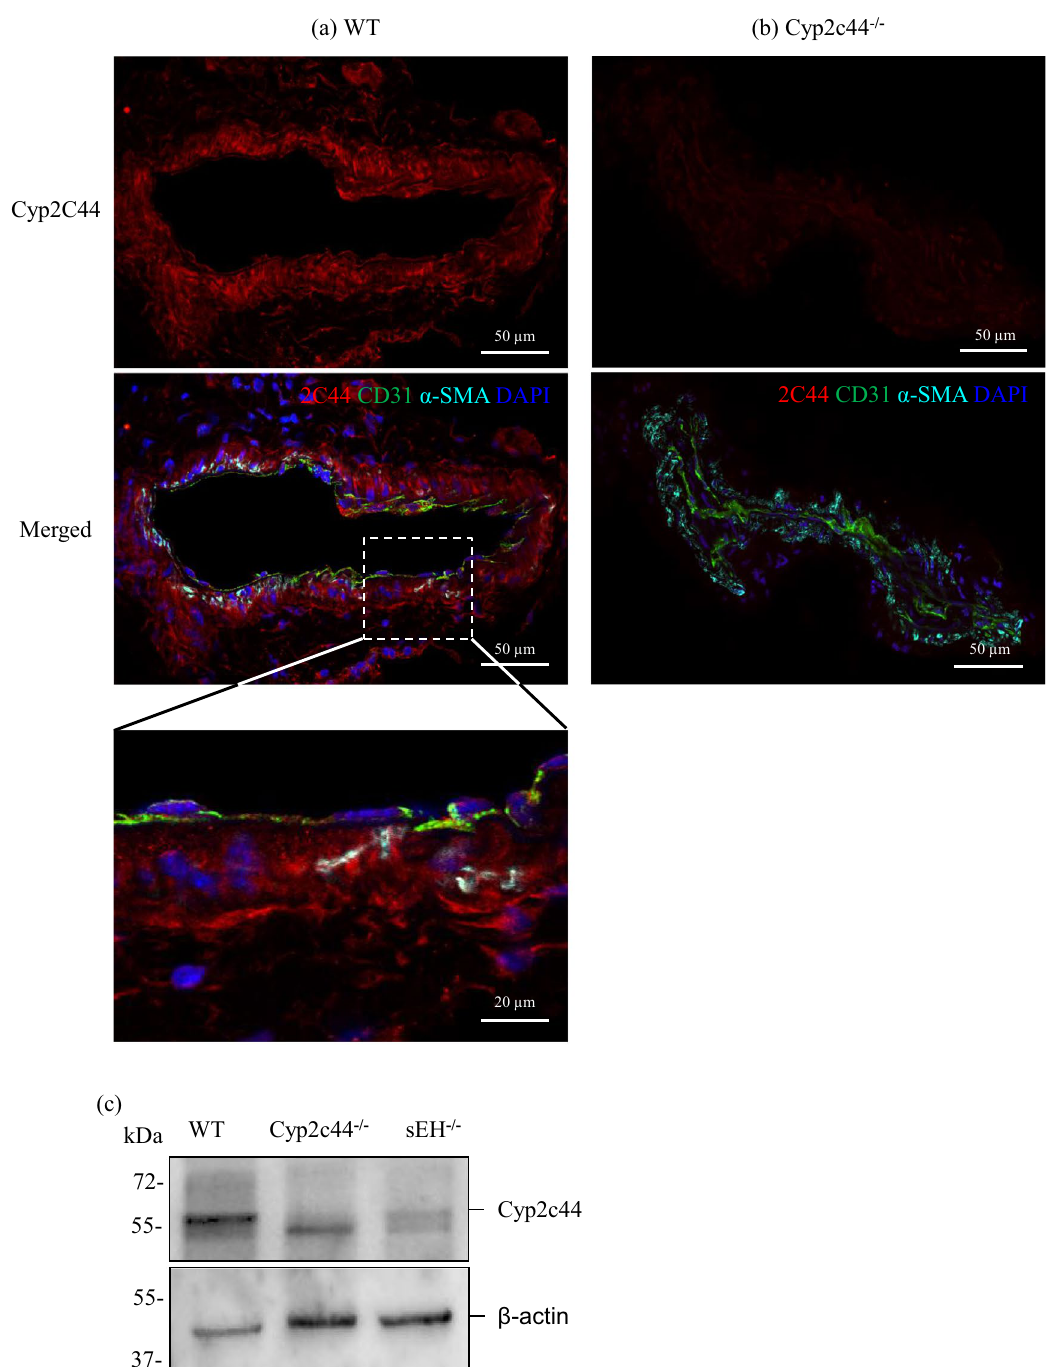
Figure 1. Expression and localization of Cyp2c44 in the mouse ophthalmic artery. Representative photomicrographs depicting the expression of Cyp2c44 in sagittal cryosections of the ophthalmic artery from ( a ) wild type (WT) and ( b ) Cyp2c44 −/− mice using immunofluorescence staining. The magnified section of the artery shows the localization of this enzyme (in red) predominantly in the vascular smooth muscle cells stained with α-SMA (in cyan). Endothelial cells were stained green with CD31 and cell nuclei were stained blue with DAPI. ( c ) Western blot analysis of Cyp2c44 in the WT artery compared to Cyp2c44 −/− and sEH −/− arterial samples. Cyp2c44 protein level was normalized to β-actin. Scale bars indicate 50 µm and 20 µm for lower and higher power magnification, respectively. Samples were pooled from n = 5 mice/ WT and n = 6 mice/ Cyp2c44 −/− and sEH −/− each, per Western blot analysis. The Cyp2c44 and β-actin bands were cropped from full gels (Supplementary Fig. S1